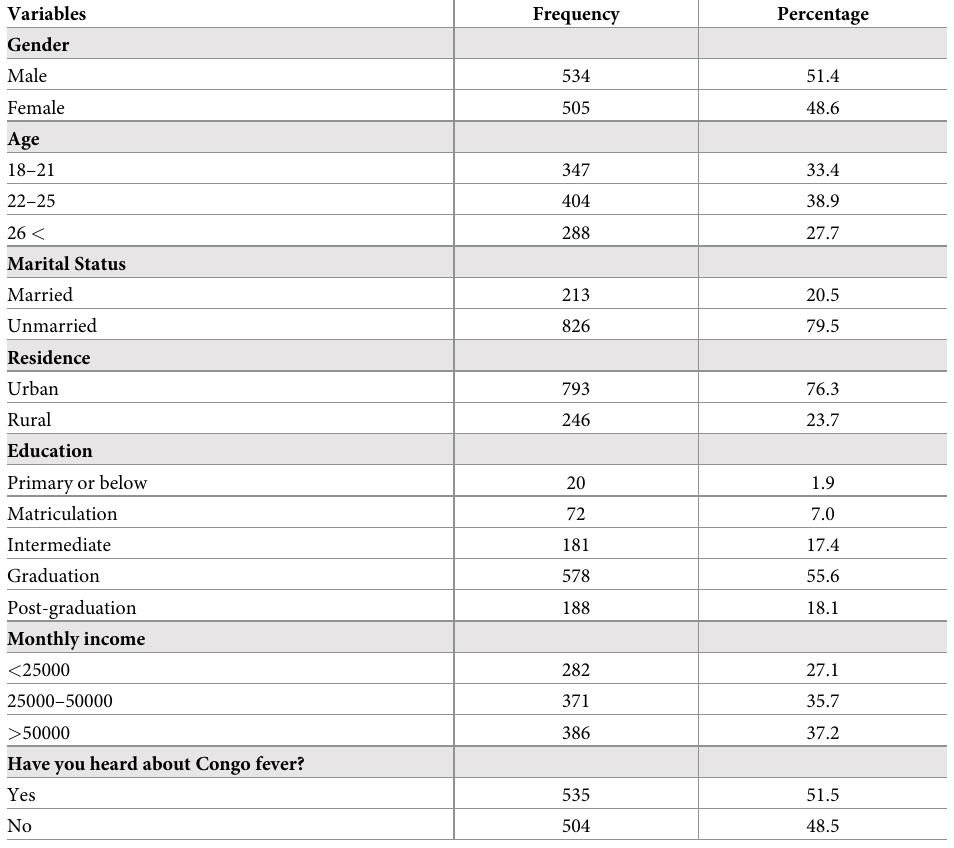
Table 1. Study samples’ socio-demographic characteristic ( N =